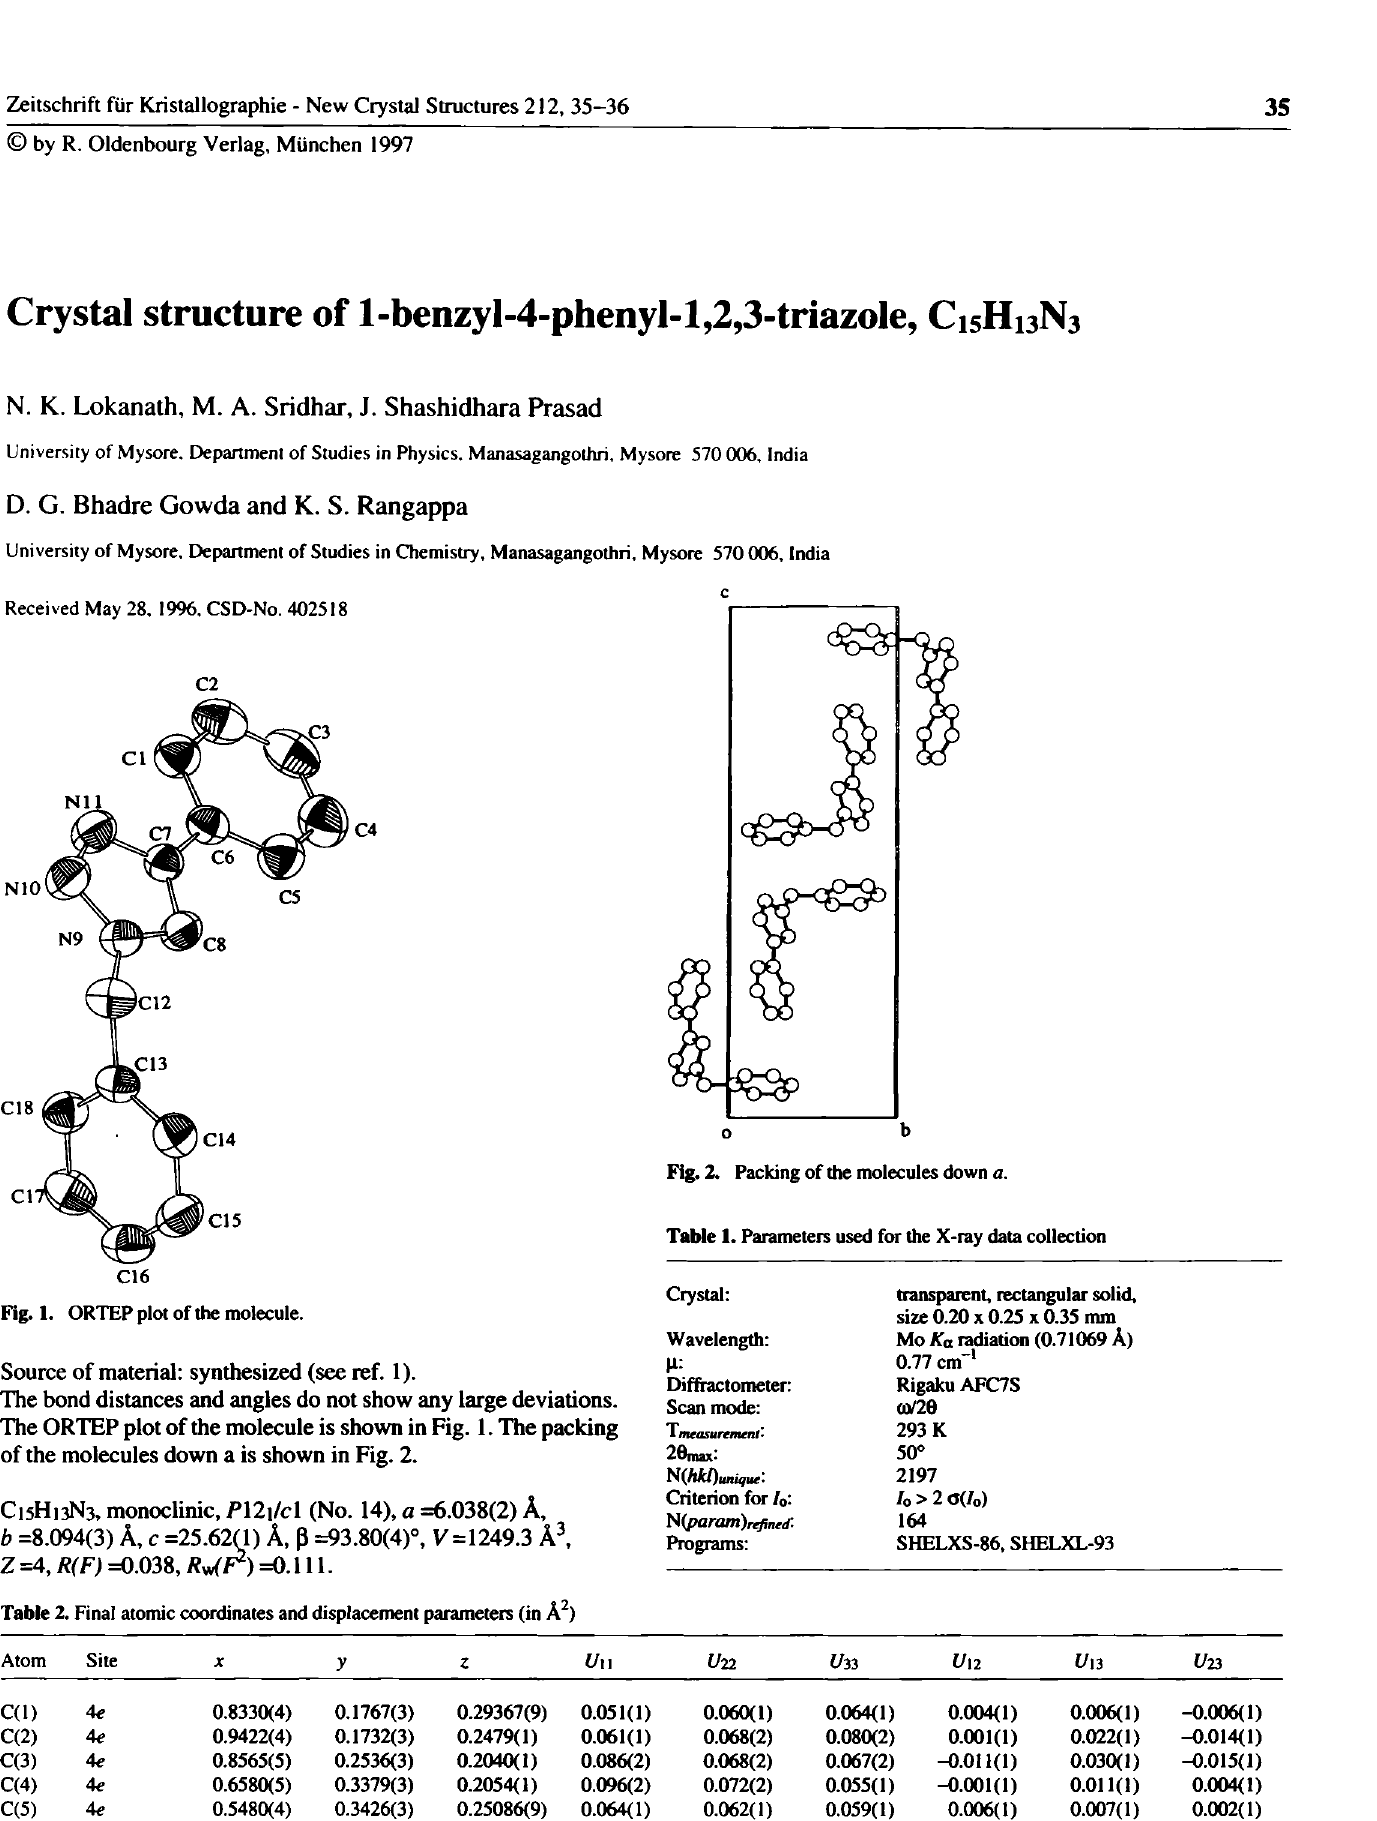
Table 2. Final atomic coordinates and displacement parameters (in Â 2